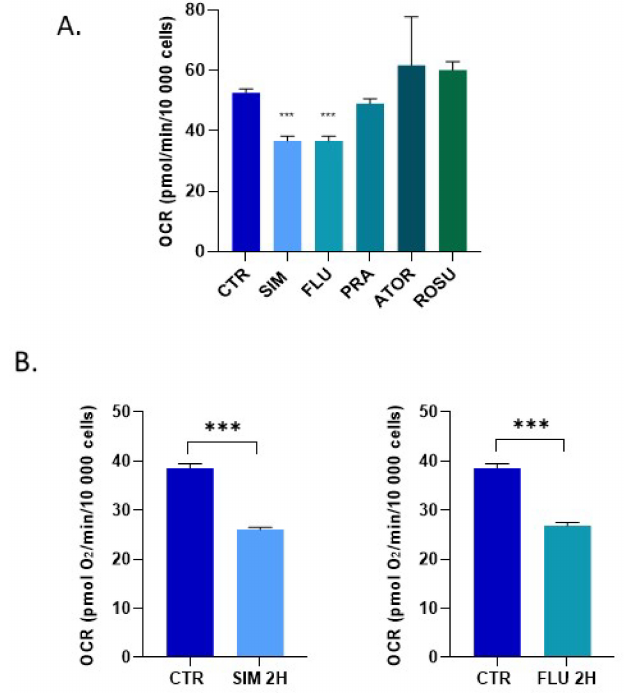
Figure 2. Impact of statins on the oxygen consumption rate (OCR) by prostate cancer cells as measured by Seahorse XF96. ( A ) effect of a 24 h exposure to five different statins (10 µ M) on the OCR of PC-3 cells; ( B ) effect of a 2 h exposure to simvastatin and fluvastatin (10 µ M) on the OCR of PC-3 cells. Bars represent means ± SEM (pmol O 2 /min/10,000 cells), (***) p < 0.001, one-way ANOVA & Student’s t -test, n = 5.